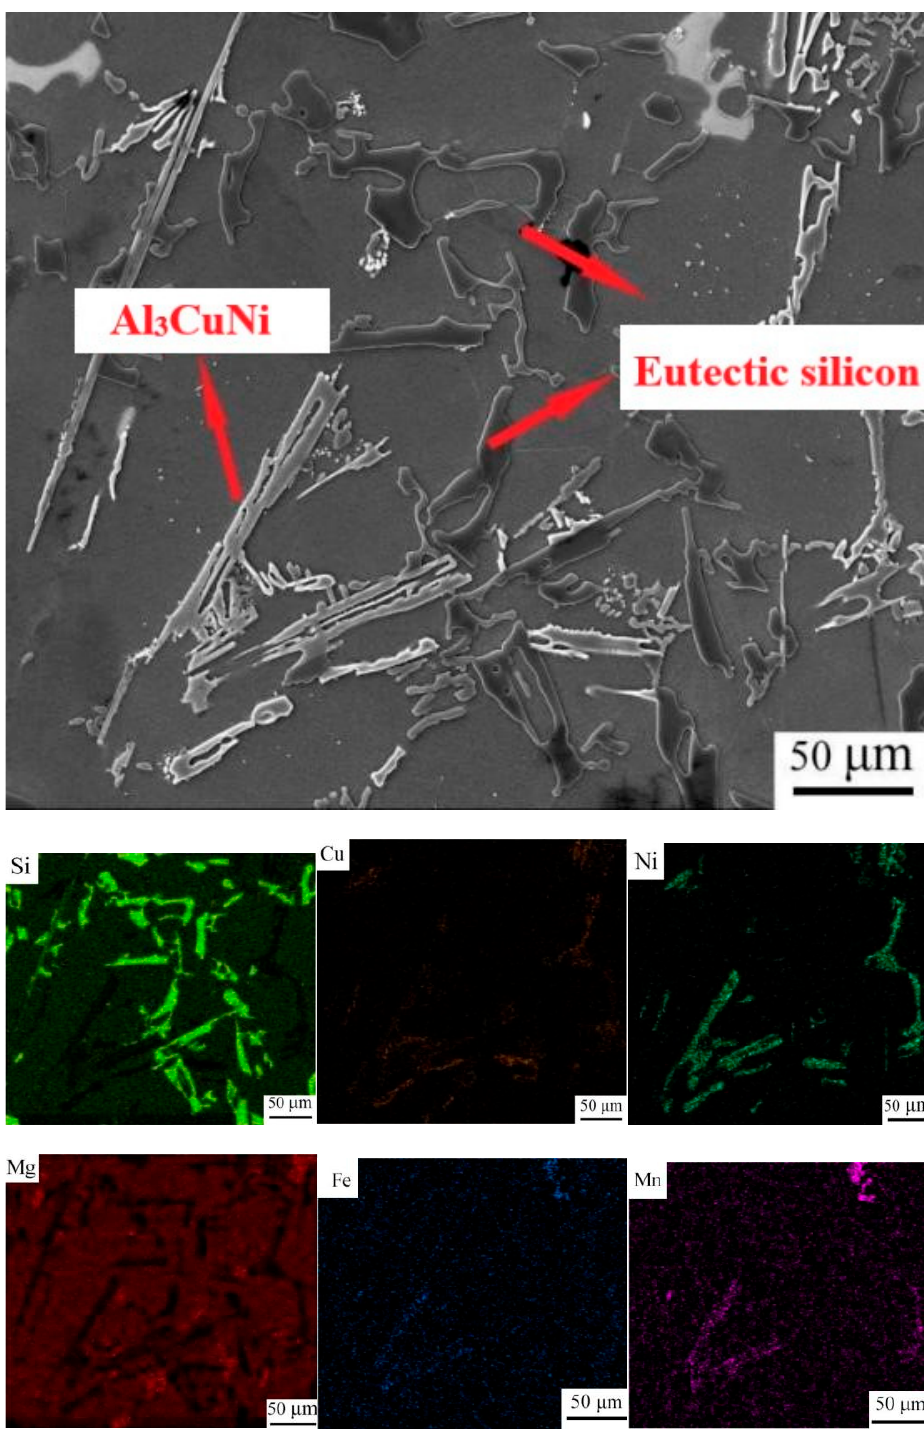
Figure 4. SEM morphology of as-cast Al-Si-Cu-Ni-Mg alloy and distribution of alloy constituent